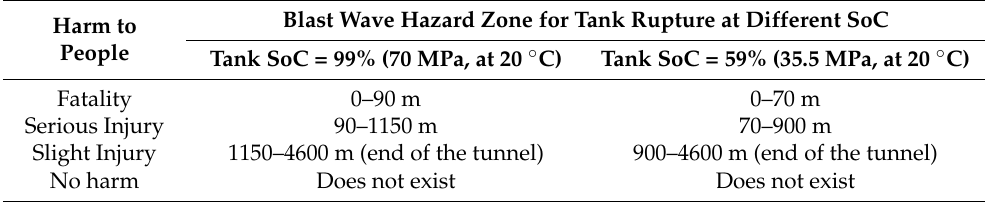
Table 3. Hazard zones from the blast wave after the tank rupture inside one tube of the tunnel. Blast Wave Hazard Zone for Tank Rupture at Different SoC Harm to People Tank SoC = 99% (70 MPa, at 20 ◦ C) Fatality 0–90 m Serious Injury 90–1150 m 70–900 m Slight Injury 1150–4600 m (end of the tunnel) 900–4600 m (end of the